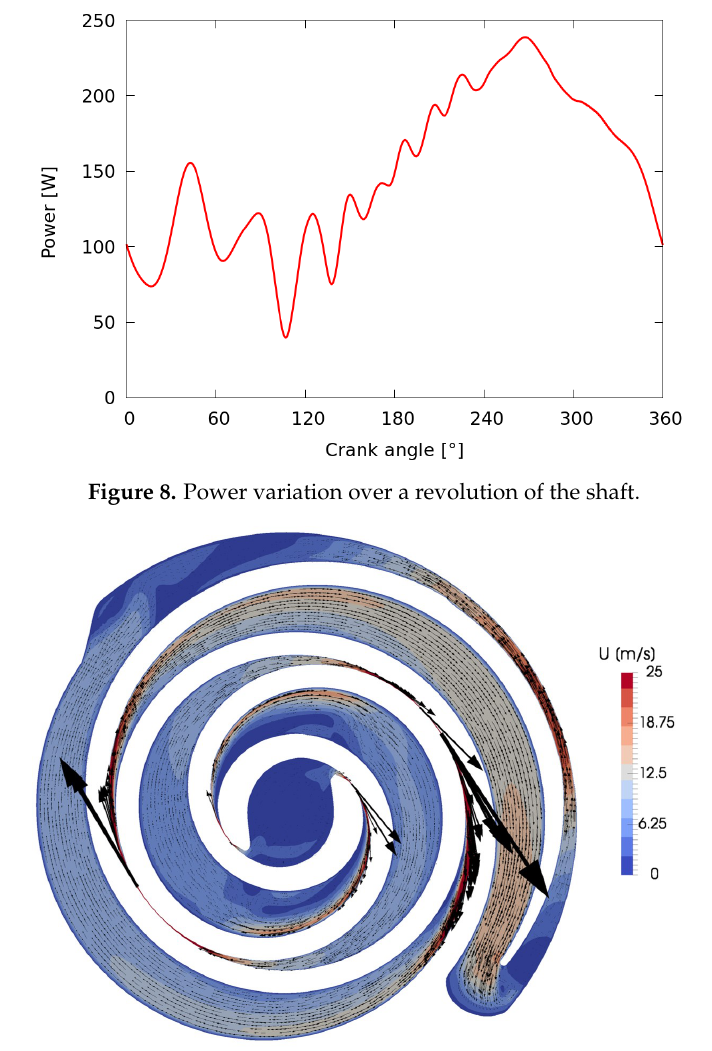
Figure 9. Velocity distribution in the domain: The arrow size is scaled by the local velocity